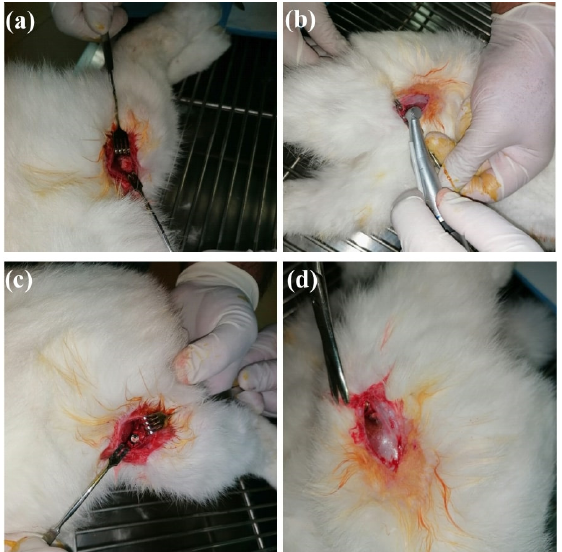
Figure 2. Surgical steps for the correct positioning of the 3D Ti implant: ( a ) exposure of lateral side of the distal femur, with visualization of the cortical bone; ( b ) opening hole drilled through the cortical bone using a dental burr; ( c ) insertion of the implant into the bone socket in a press-fit manner; ( d ) cover and protection of the implant by soft tissues and closing of the wound.